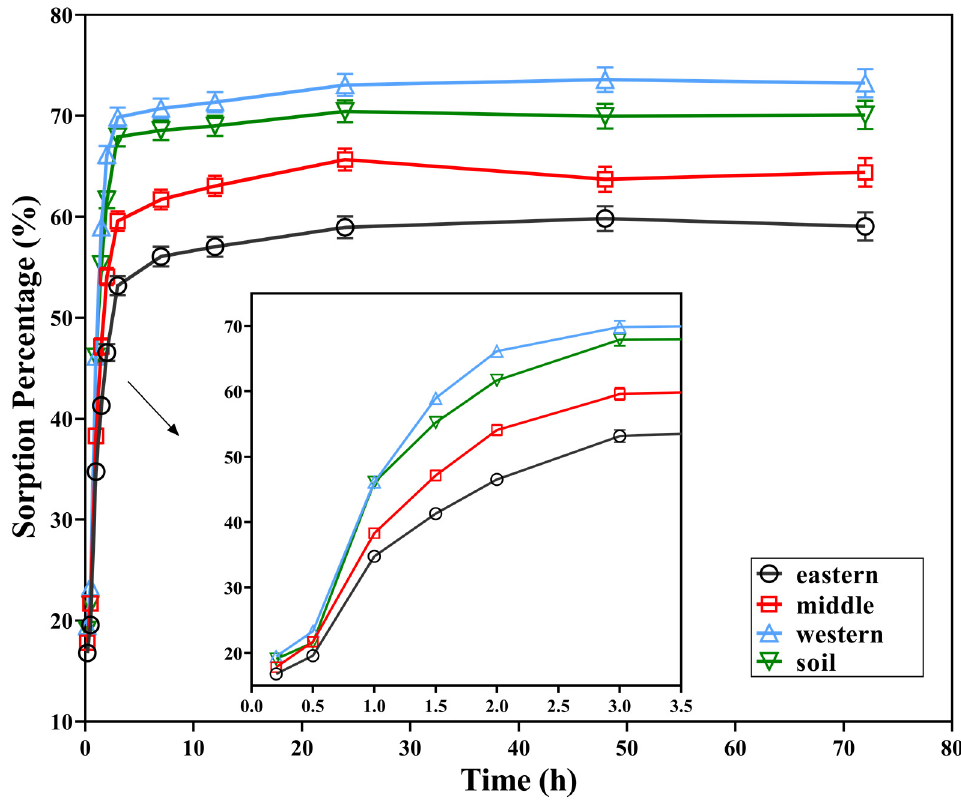
Figure 2. Sorption curves of 2,3,7,8-TCDT in three sediments from Chaohu Lake and paddy soil.